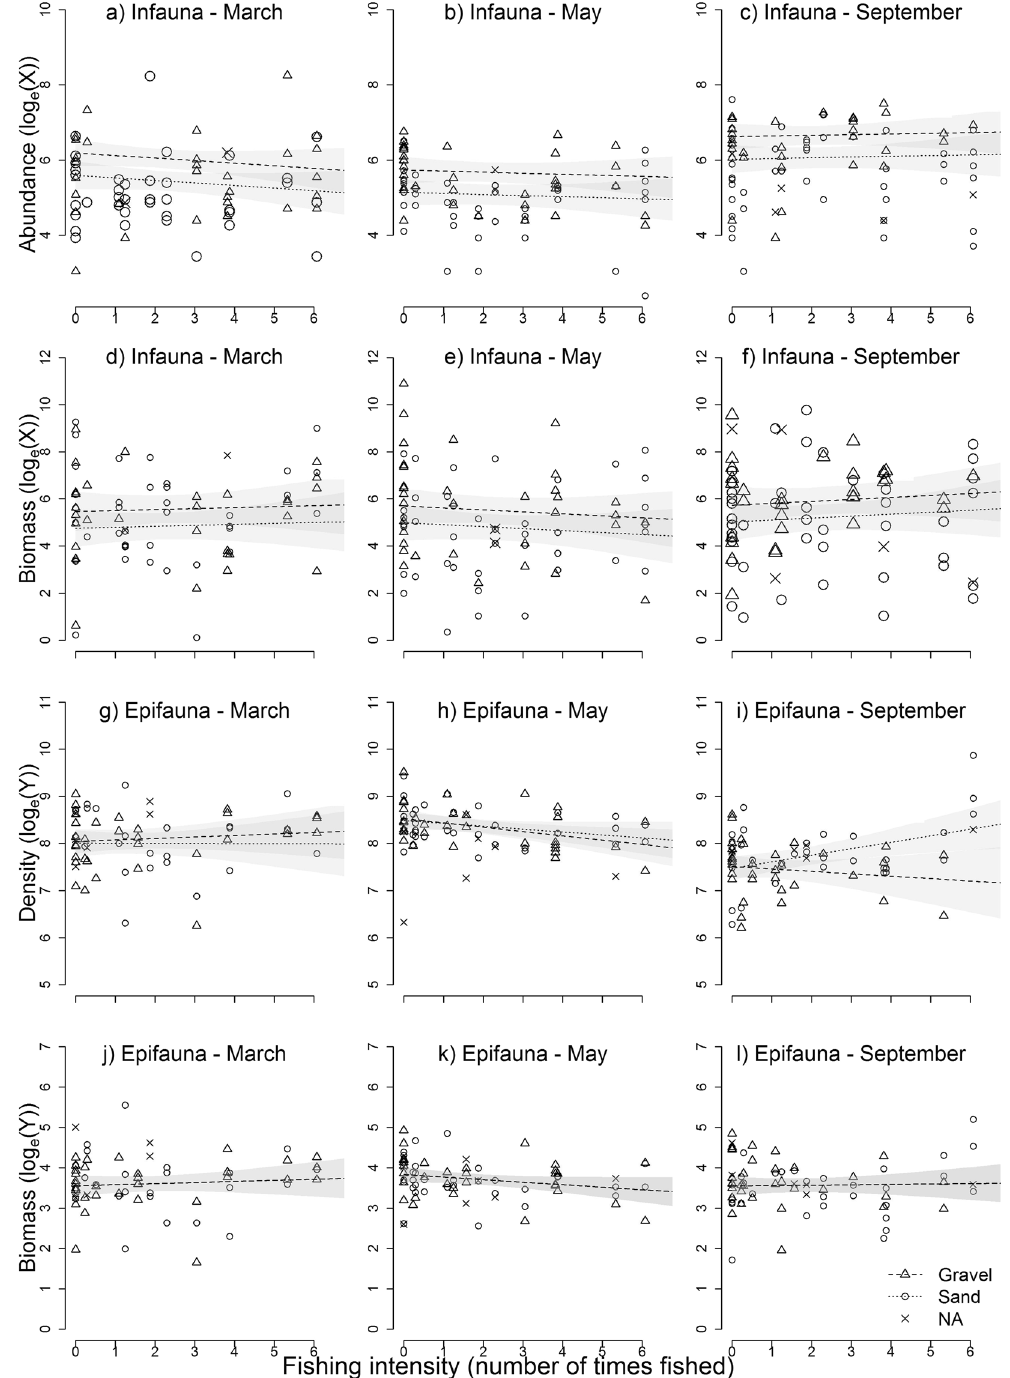
Figure 2. Effect of scallop dredging on total community infaunal ( a–f ) and epifaunal ( g–l ) abundance and biomass (excluding P. maximus and O. fragilis from the epifaunal analysis). Left to right: March (prior to fishing), May (after fishing) and September (four months after fishing). X is for infauna, measured in number of individuals (x10 + 1) or weight in grams (x100 + 1) per 0.1 m 2 . Y is for epifauna measured in density of individuals (x100 + 1) or weight in kgs (x100 + 1) per 100 m 2 . Each symbol is a sample, distinguishing sand and gravel types, and NA for samples where no sediment information were available (i.e. data not included in the models). Lines show the predicted values from best models with 95% confidence intervals (grey shading) (all models included fishing intensity, survey time and their interaction and other fixed effects as specified in Table